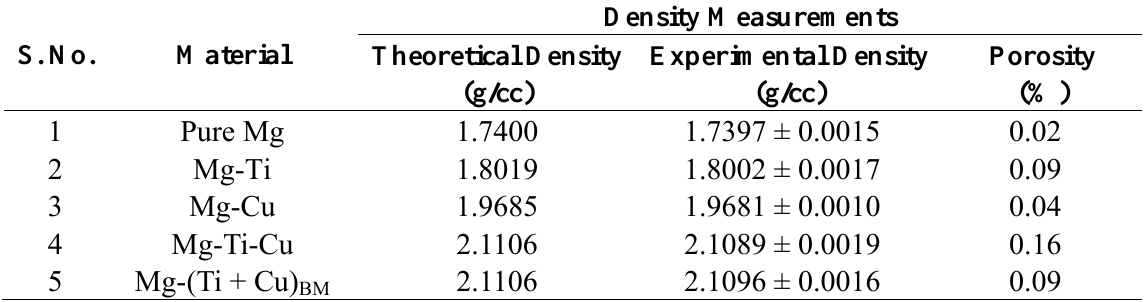
Table 1. Results of density and porosity